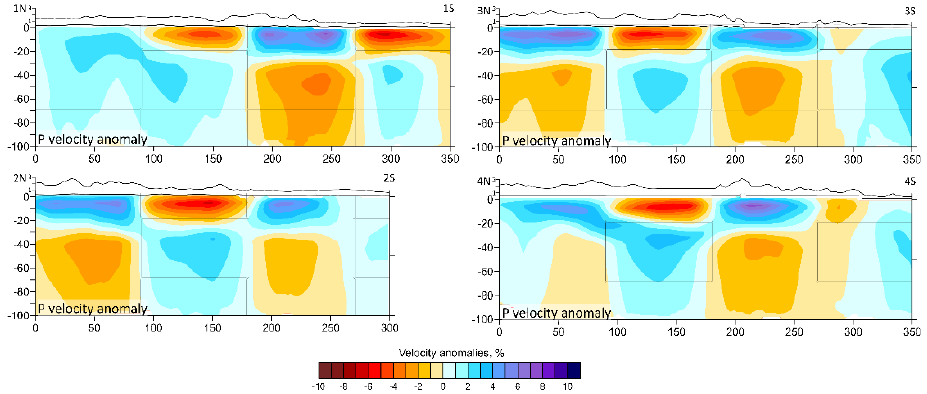
Figure 7. Vertical checkerboard test.